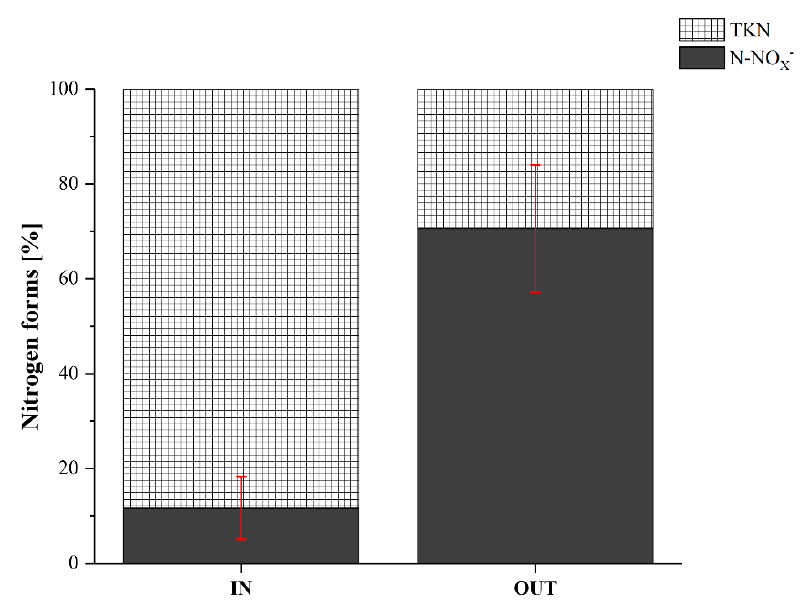
Figure 4. The components of the TN as a percentage by comparing the concentration of the influent GW and of the HFCW effluent in the phase P2 (HRT = 3 days). The red bars indicate the 95% confidence intervals.